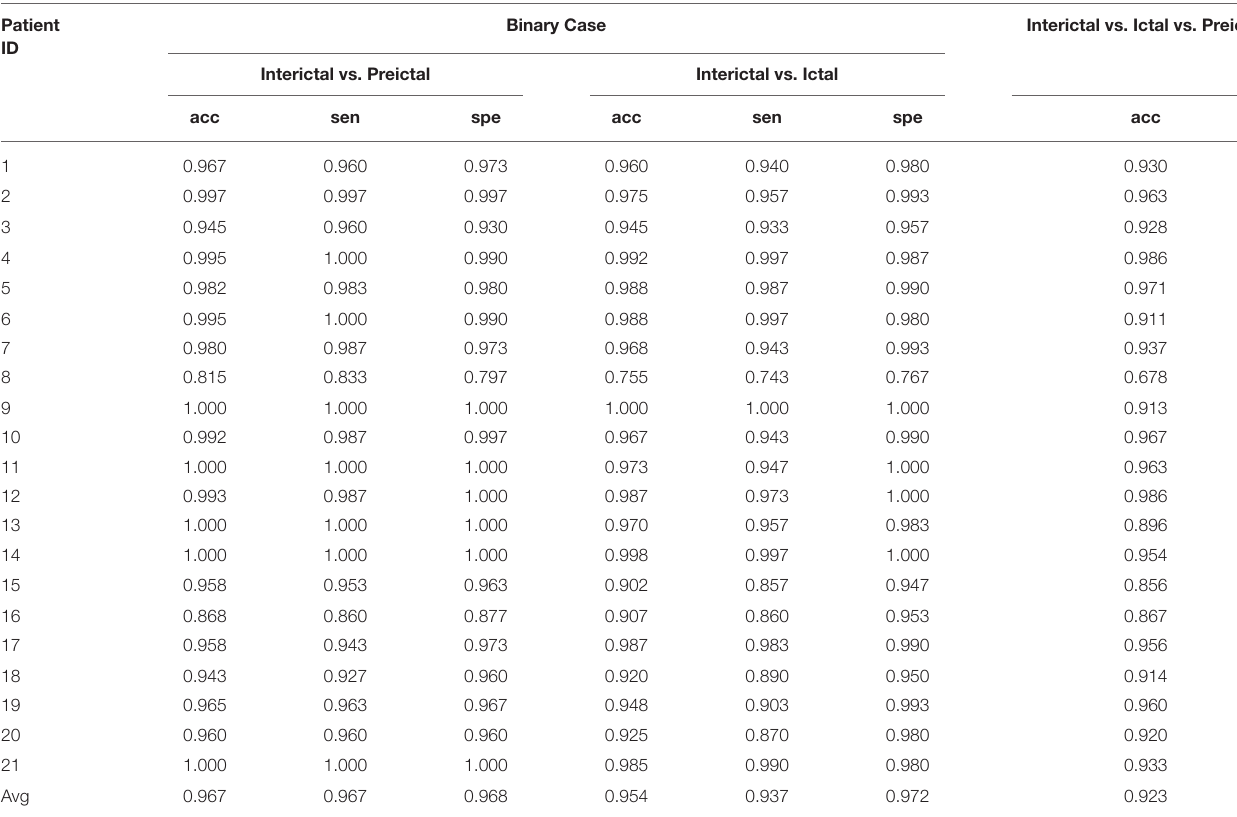
TABLE 1 | Frequency domain signal results for all patients in the Freiburg database. Patient